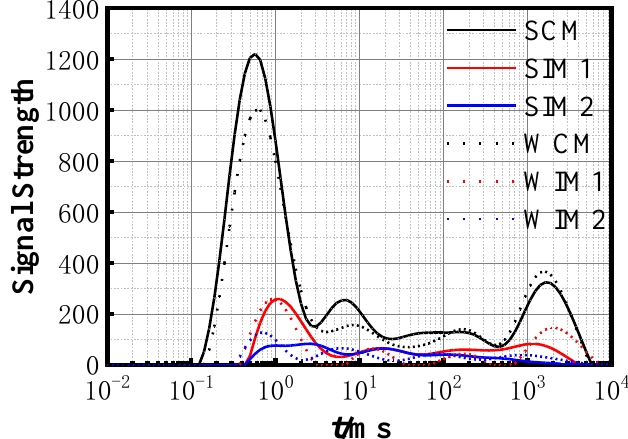
Figure 14. Distribution of T 2 spectra of specimens with ages of the same sand rate generation. Using the CM group without tailings as the reference group, with the prolongation of the curing age, the level of microporosity decreases in the CM group, and the number of medium and large pores does not change much. The IM1 group with 25% sand substitution rate shows a little change in microporosity, but the number of medium-sized pores decreases, and large-sized pores increase. The IM2 group with 50% sand substitution rate shows an increase both in the microporosity and number of large pores, while the number of medium-sized pores decreases. However, the magnitude of the changes in these two IOTC groups is much smaller than in the CM reference group.